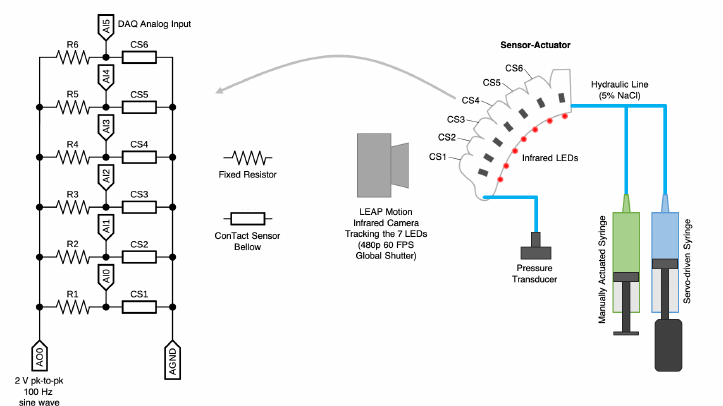
Figure 2. Soft hydraulic robotic finger system diagram using hybrid sensor–actuators. Each of the sensing elements (CS1-CS6) spans a bellow of the hydraulic bellows-style actuator. A series of infrared LEDs provides an external “ground truth” of the robot pose for training and performance